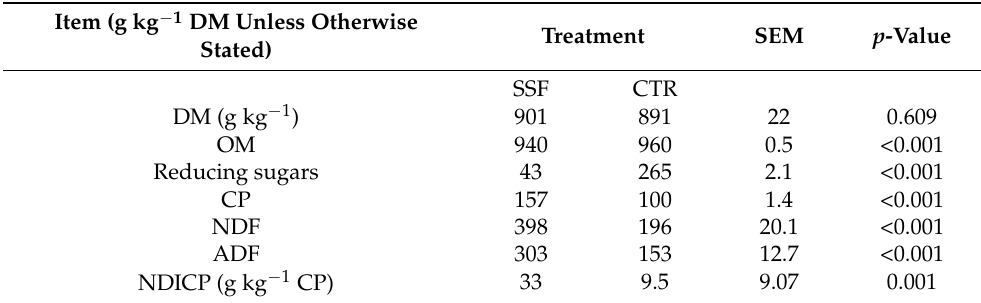
Table 1. Effect of solid state fermentation process on the chemical composition of fruit and vegetable mix discards.